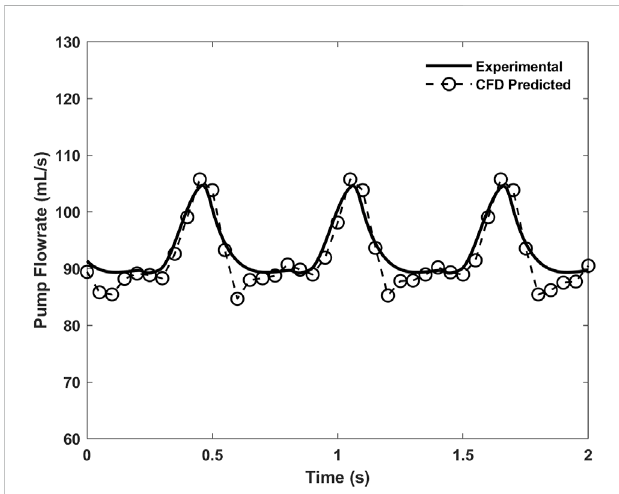
Time-varyingpump fl owratespredicted byCFDsimulationandthe corresponding experimental data under the 3,000 rpm constant speed